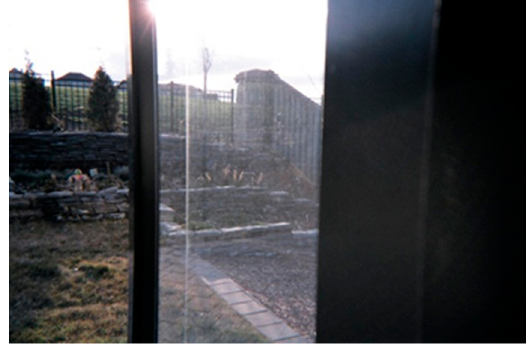
Figure 2. The stony path to balance.